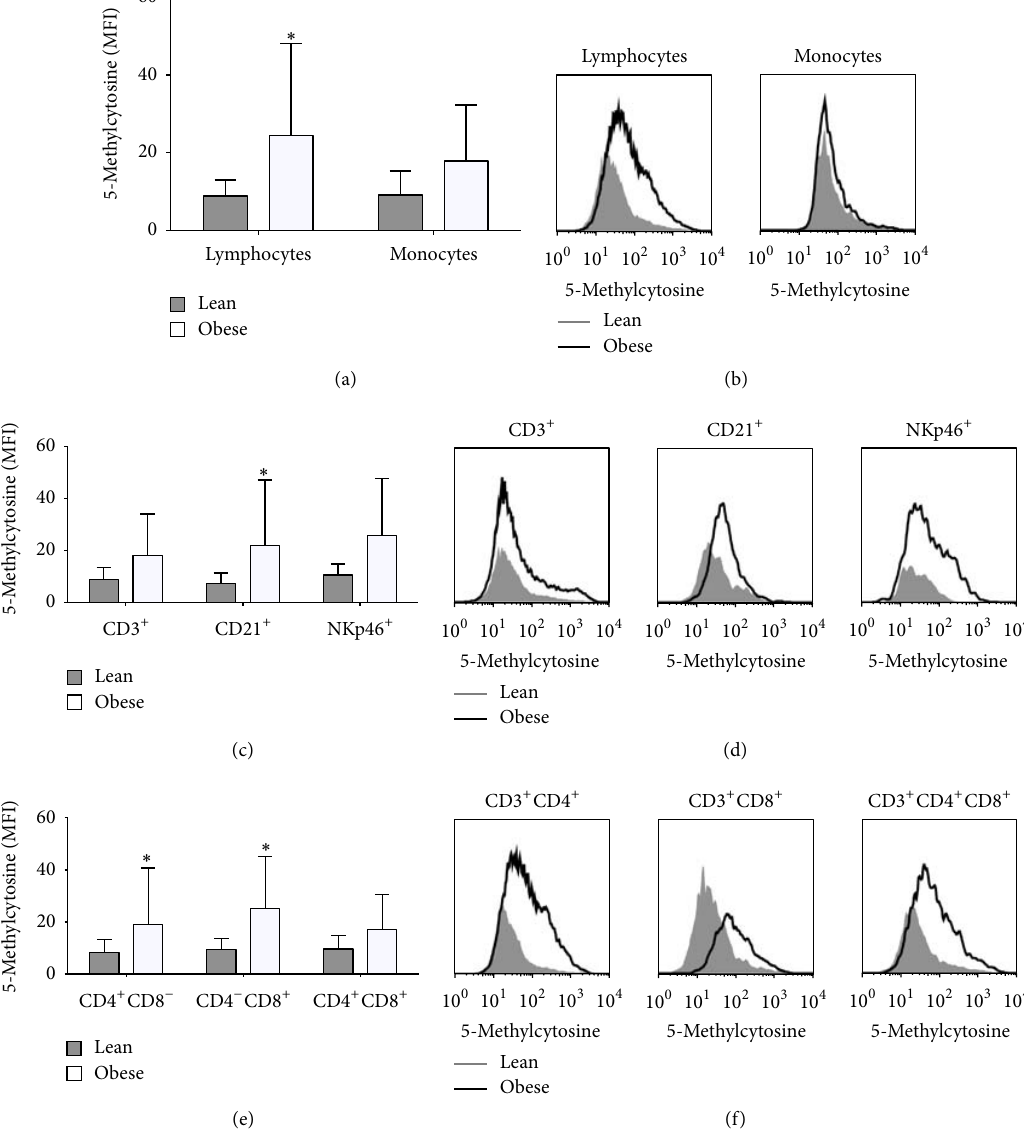
Figure 4: Global DNA methylation in PBMCs subpopulations from lean (grey columns and histograms) and obese pigs (open columns and histograms). (a) Representative quantification of 5-methylcytosine levels in lymphocytes and monocytes. (b) Quantification of 5- methylcytosine levels (MFI) in lymphocytes and monocytes. (c) Representative quantification of 5-methylcytosine levels in T-cells (CD3 + ), B- cells (CD21 + ), and natural killer cells (NKp46 + ). (d) Quantification of 5-methylcytosine levels (MFI) in T-cells, B-cells, and natural killer cells. (e) Representative quantification of 5-methylcytosine levels in T-cells subpopulations: T-helper (CD3 + CD4 + ), T-cytotoxic (CD3 + CD8 + ), and double positive T-cells (CD3 + CD4 + CD8 + ). (f) Quantification of 5-methylcytosine levels (MFI) in T-helper, T-cytotoxic, and double positive T-cells. Data are mean ± SD. ∗ 𝑝 < 0.05 . MFI: median fluorescence